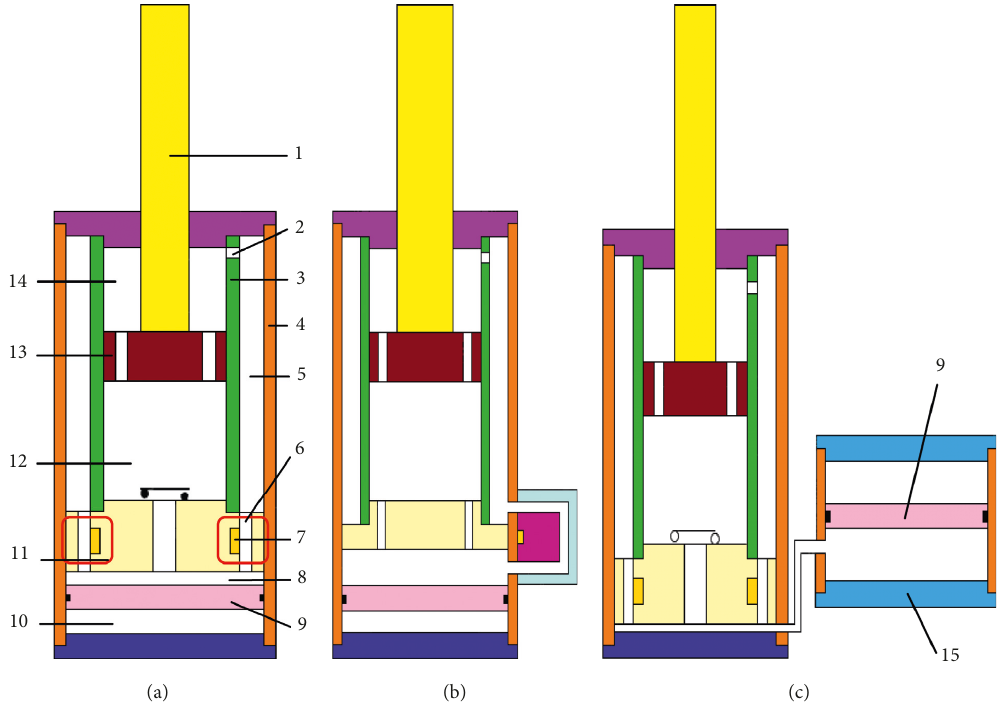
Figure 12: A schematic view of a twin-tube MR damper: (a) the coil arranged in a groove of the foot valve, (b) the side location of the MR valve, and (c) the gas chamber installed in an external valve. 1, piston rod; 2, inlet passage; 3, inner tube; 4, outer tube; 5, outer chamber; 6, passageways; 7, coil; 8, lower chamber; 9, moveable wall; 10, gas chamber; 11, foot valve (including lower one-way valve); 12, compression chamber; 13, piston (including upper one-way valve); 14, rebound chamber; 15, reservoir [55].